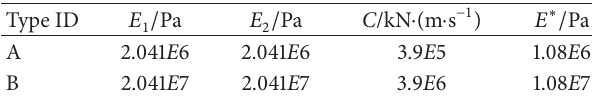
Table 3: Parameters of the additional